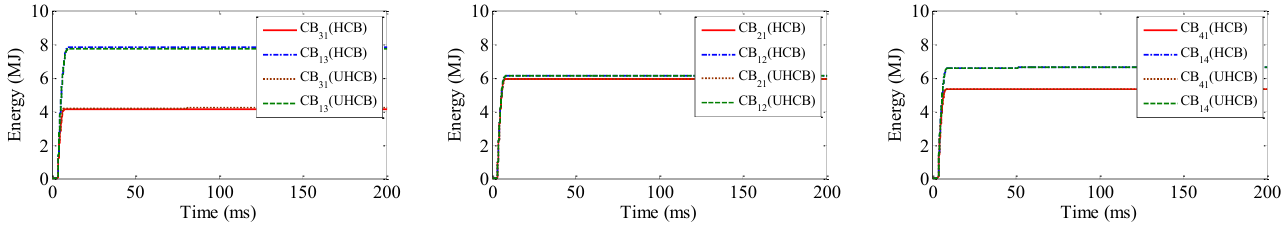
parallel diode (D). The L L , R v and T cb represent the limiting inductor, surge arrester and the circuit breaker operation time delay, respectively. The value of limiting inductor ( L L ) of the line DCCBs is set to 100 mH. The L L for the converter